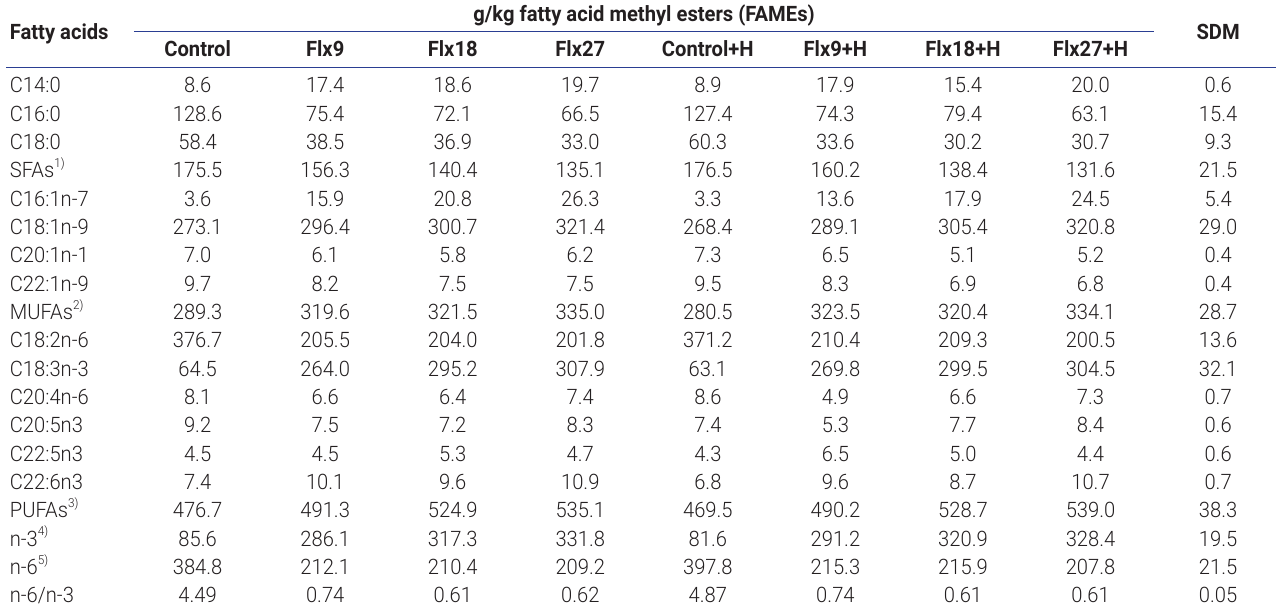
Table 2. Fatty acid compositions of test diets with different levels of flaxseed and without herbal medicines fed to laying hen for nine weeks Fatty